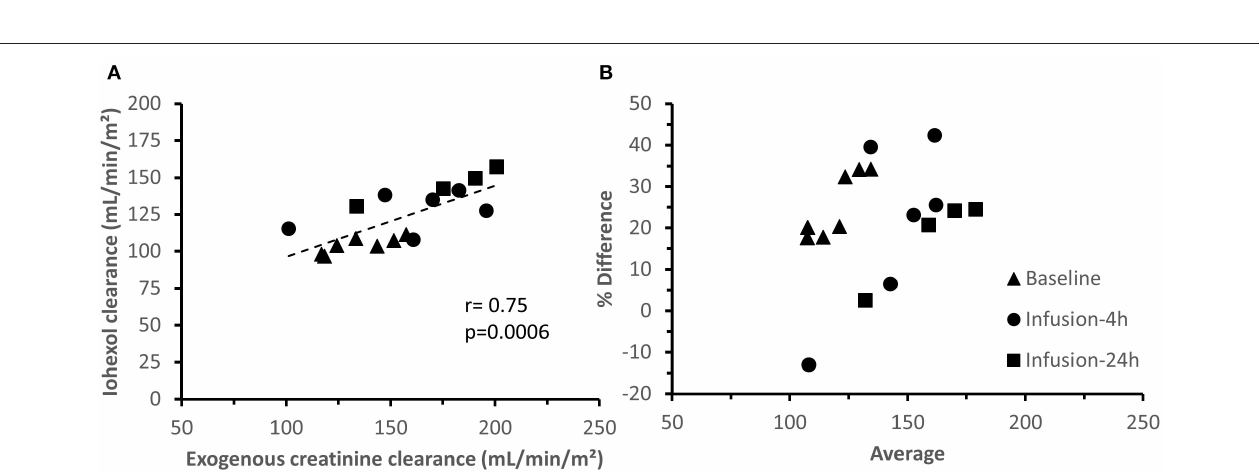
FIGURE 6 | Correlation (A) and agreement (B) between iohexol and creatinine total body clearances. B presents a Bland-Altman plot of the difference between iohexol and creatinine clearance, expressed as percentage [(creatinine clearance—iohexol clearance)/average)] vs. the average of the clearances. The measurements at the distinct measuring periods are depicted with different